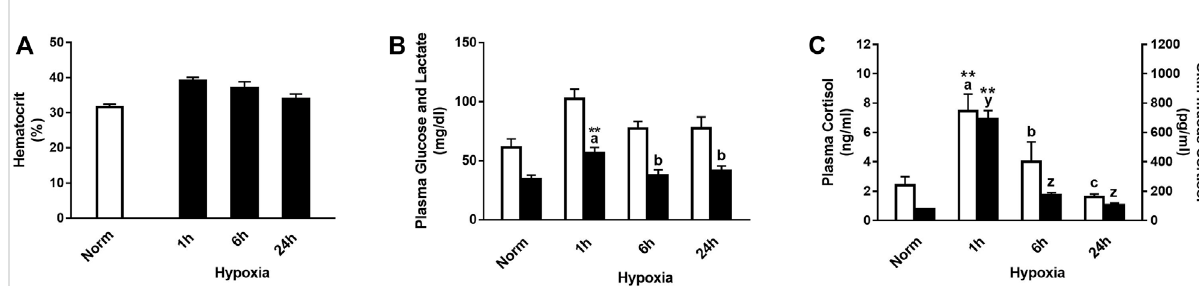
FIGURE 1 (A) Hematocrit, (B) plasma glucose (white bars) and lactate (black bars), and (C) plasma cortisol (white bars) and skin mucus cortisol (black bars) inrainbowtroutafternormoxiaandafteracutehypoxiawithdifferentrecoverytimes(1 h,6 h,and24 h).Thevaluesarepresentedasmean+SEM( n = 8). Signi fi cant differences between time points after hypoxia are shown by letters; between hypoxia-treated and normoxia are shown by * ( p < 0.05) or ** ( p <